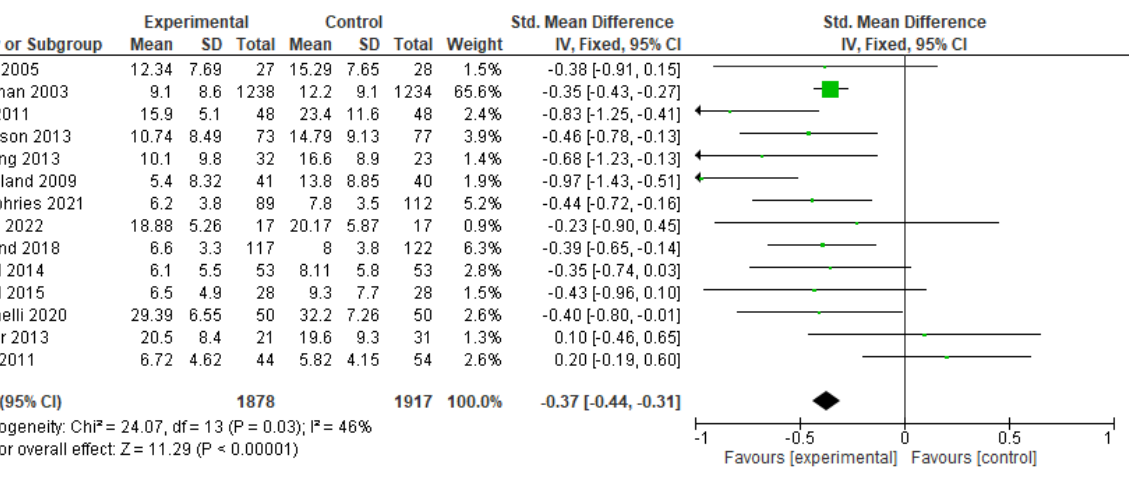
Figure 5. Forest plot describing efficacy of CBT in reducing depression among patients with CHD [29–33,35–39,41–43,47]. The arrow symbol in the figure shows the standard mean difference range and the green box shows the standard mean difference in each study.